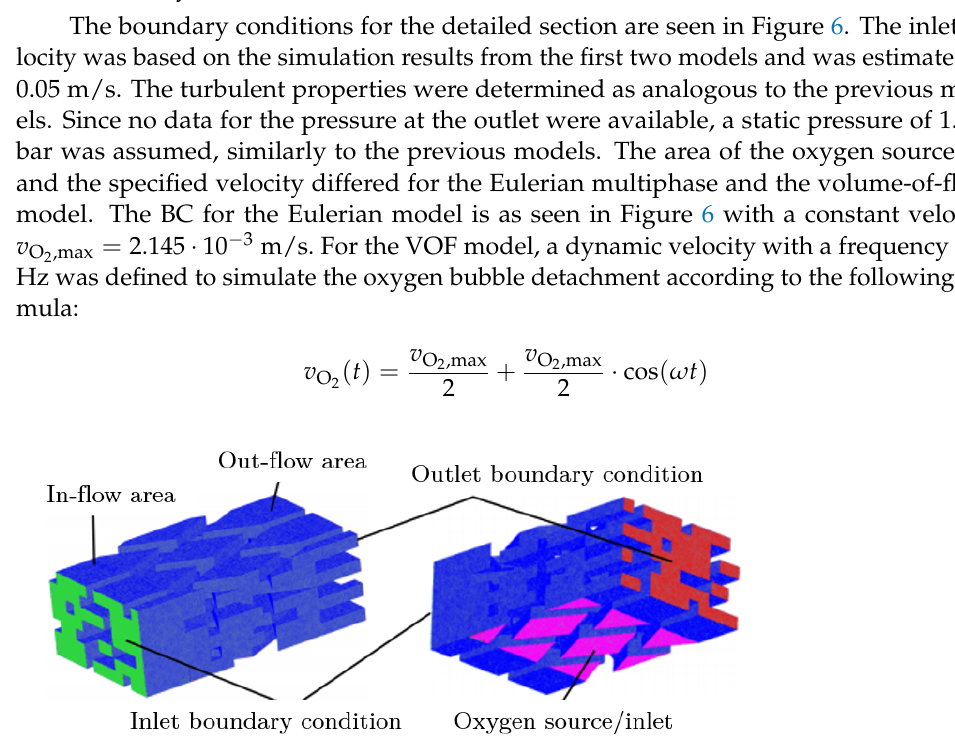
Figure 6. Boundary condition for the detailed Eulerian